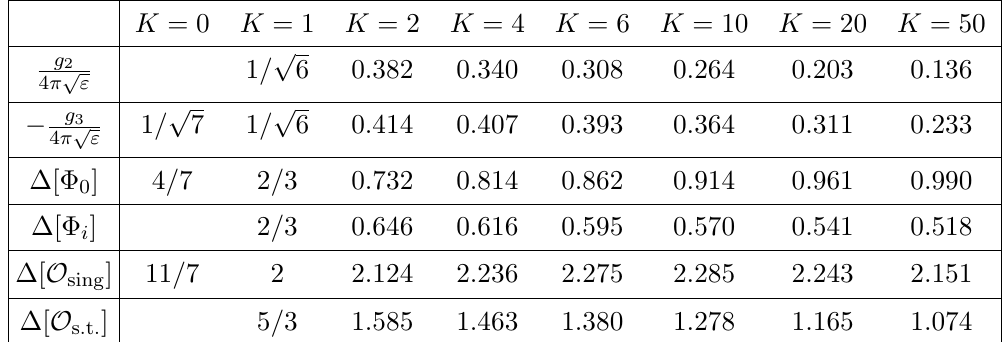
Table 1 . The Wess-Zumino model W = g 2 at the IR (cid:12)xed point and scaling dimensions of the elementary and quadratic operators. We